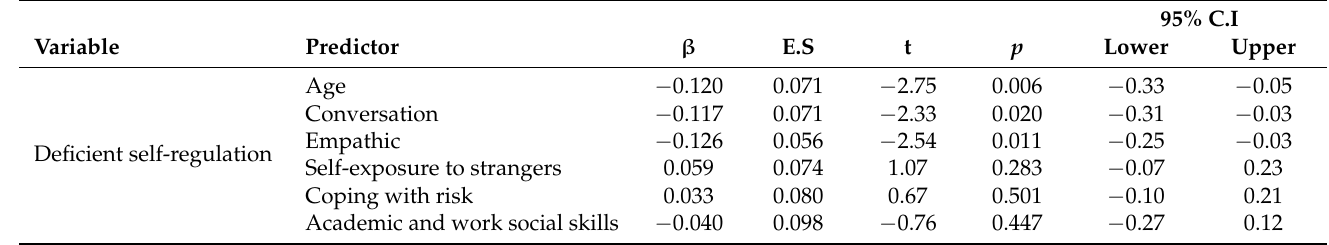
Table 5. Summary of the multiple linear regression model for deficient self-regulation variable in line with the predictor variables included in the